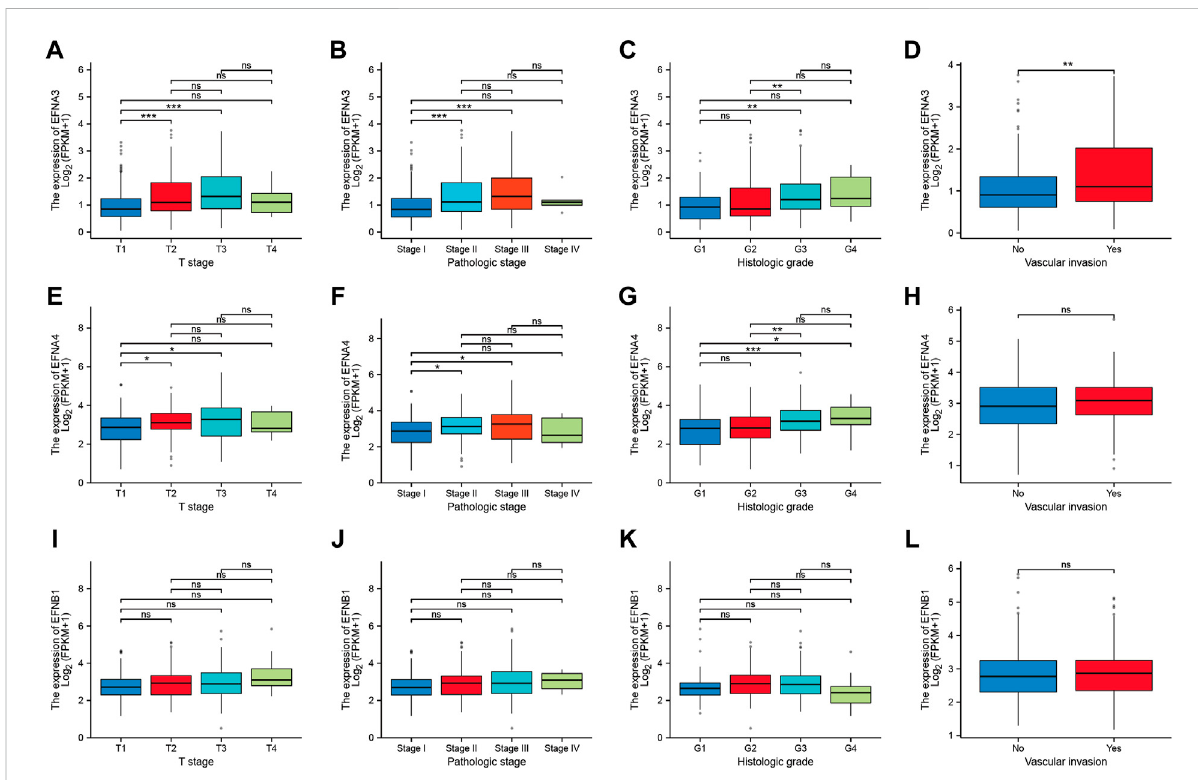
FIGURE 4 Correlation between prognosis-related ephrins and tumor stage, pathological stage, histological grade, and vascular invasion status in HCC. (A – D) The differential expression of EFNA3 associated with different tumor stages (A) , pathological stages (B) , histological grades (C) , and vascular invasion (D) . (E – H) The expression levels of EFNA4 for different tumor stages (E) , pathological stages (F) , histological grades (G) , and vascular invasion (H) . (I – L) The correlation between EFNB1 expression and tumor stage (I) , pathological stage (J) , histological grade (K) , and vascular invasion (L) . ns: no signi fi cance; * p < 0.05; ** p < 0.01; *** p < 0.001.